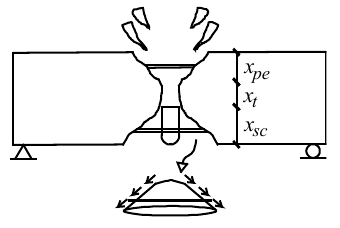
Figure 1. Scabbing-resistant energy ( E SC ).